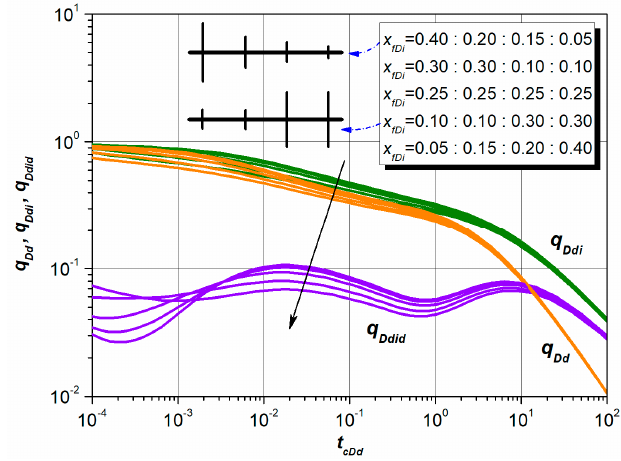
Figure 5. The effect of unequal fracture half-length on combined type curves of an MFHW.